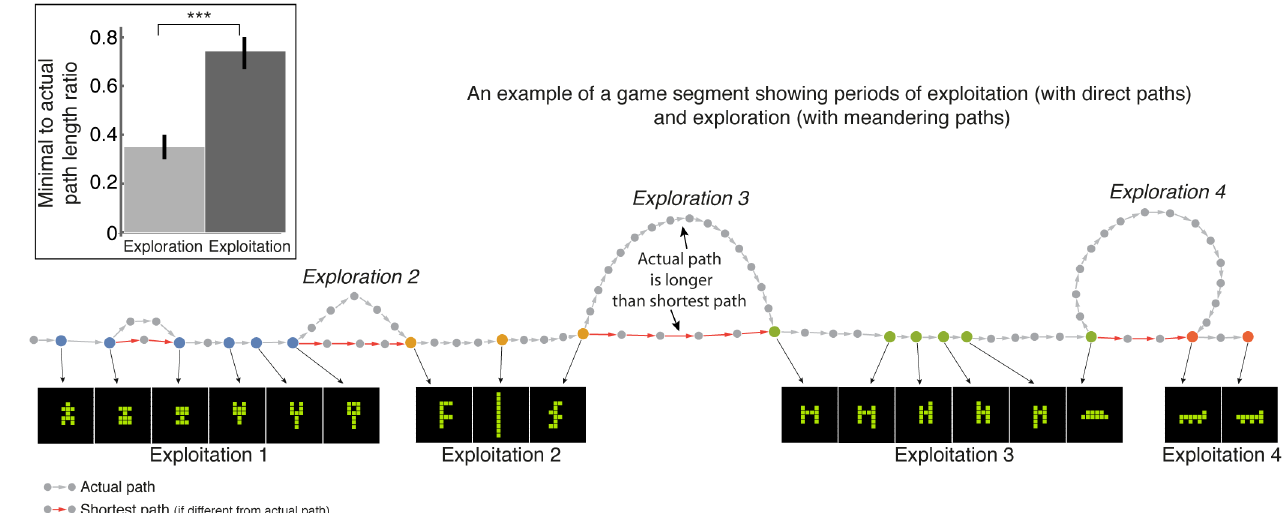
Fig 4. Participants follow optimal (shortest) paths in exploitation phases. Shownare moves (circles), gallery-chosen shapes (colored circles), actual (gray) and minimal(red) paths (minimalpath marked when different from actual path). Explorationand exploitation phases are labelled.Inset, players’ medianratio of minimalto actual path length betweengallery shapes in exploitation and exploration.